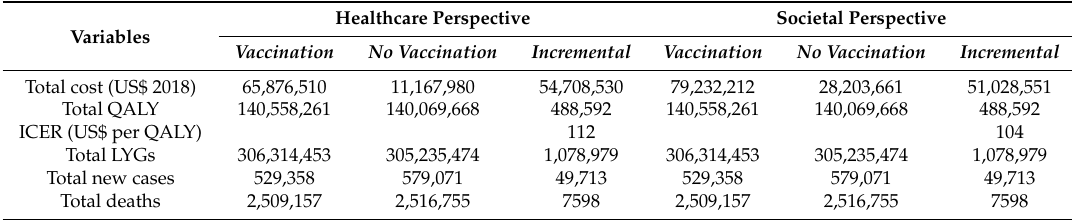
Table 2. Results of the analysis of the base-case scenario for the vaccination strategy.